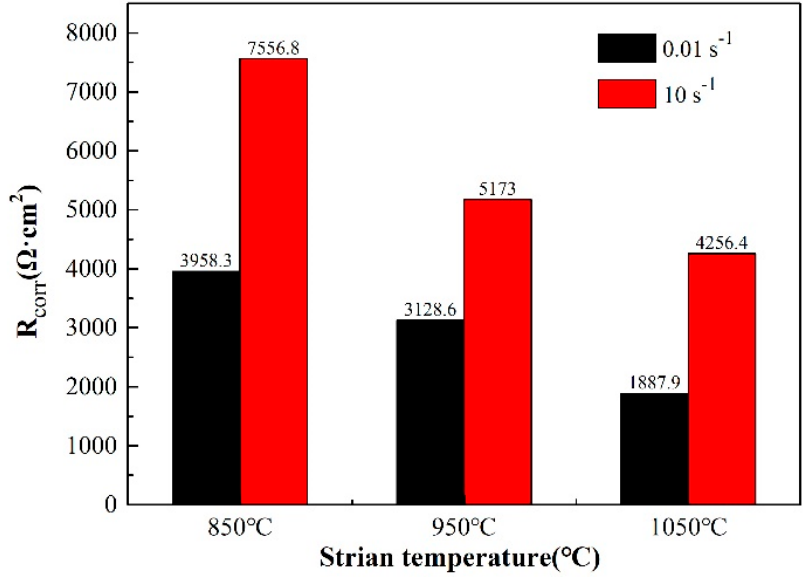
Figure 9. The corrosion rate of the 35CrMoV steel in 3.5 wt% NaCl solution.